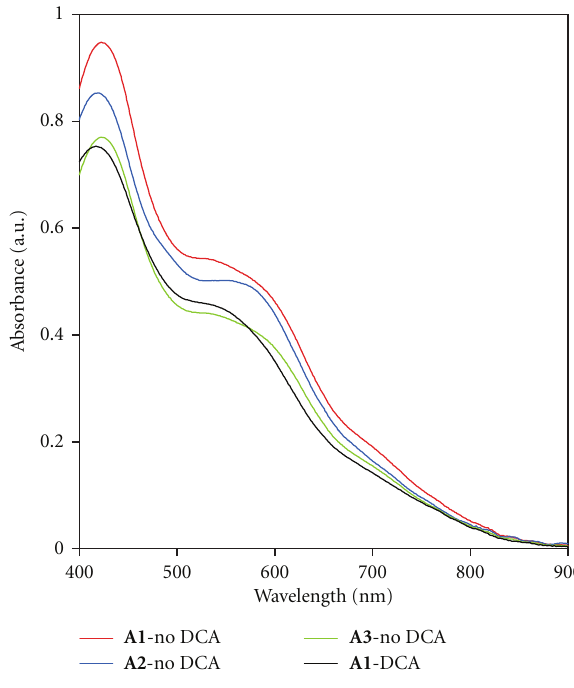
Figure 4: Absorption spectra of complexes A1 , A2 , and A3 adsorbed onto a nanocrystalline 7 μ m thick TiO 2 film.